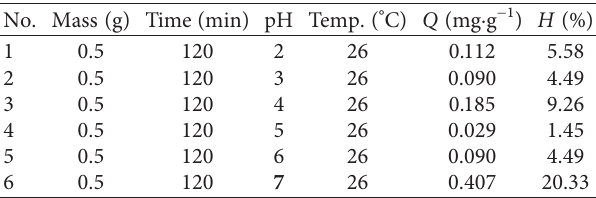
Table 4: Effect of pH on Cr (VI) ion adsorption process.